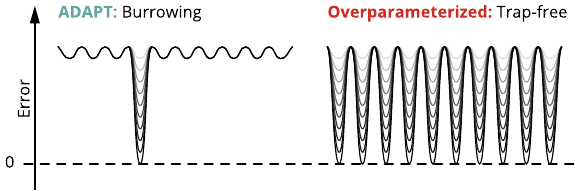
Fig. 6 Burrowing diagram. Schematic cartoon of how the parameter landscapes change as parameters are added using ( a ) ADAPT-VQE, and ( b ) a “ controllable ” or overparameterized ansatz which has a greater number of parameters than the rank of the DLA. Here the y -axis is meant to convey error, and the x -axis is meant to convey a generalized coordinate in parameter